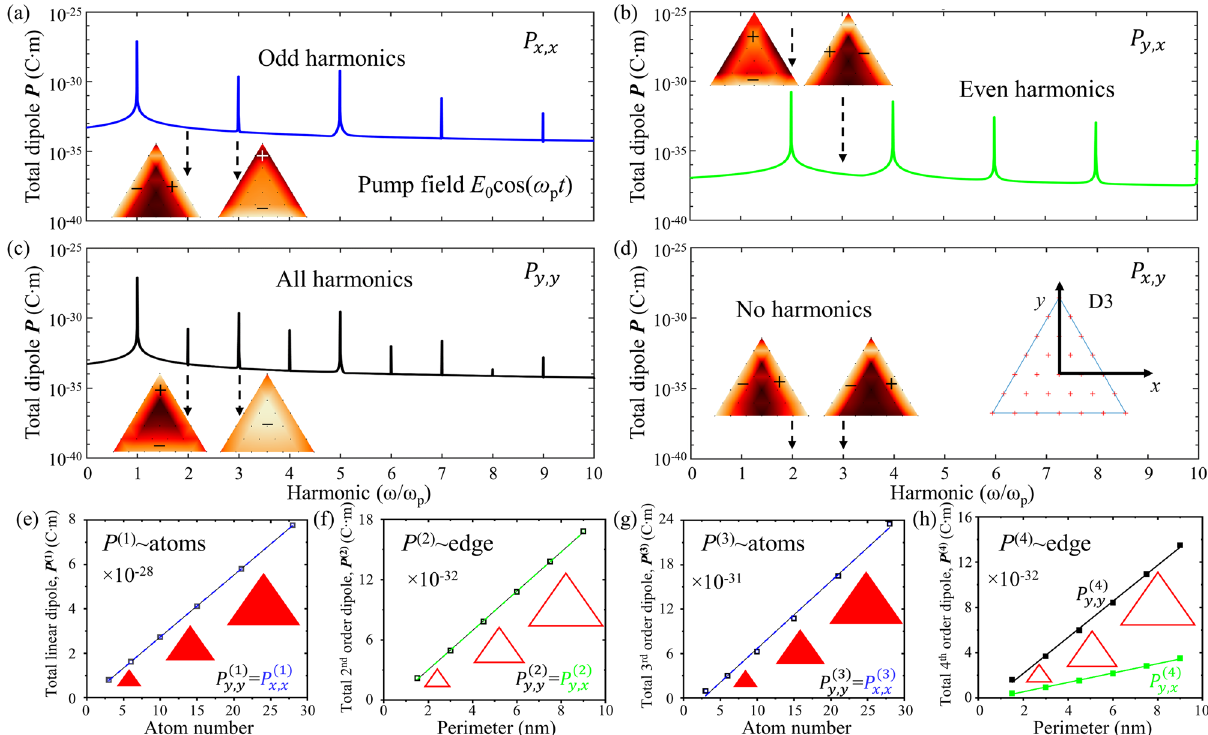
Figure 3. Harmonic generation in a nanoparticle of D3 symmetry. ( a – d ) Frequency-dependence of the electric dipole moment of a triangular particle pumped at frequency ω p . Components of the dipole moment ( a , c ) parallel and ( b , d ) orthogonal to the ( a , b ) x -polarized and ( c , d ) y -polarized pump field. Absence of curves in case ( d ) indicates cancellation of the electric dipole component at all frequencies. The inset shows the outline (blue line) and the 28 atoms (red crosses) of the triangular particle. Colourmaps show the distribution of the atomic dipole moments at the 2nd and 3rd harmonic frequencies, which are representative of even and odd harmonics. Colour represents the dipole magnitude and regions oscillating in anti-phase are indicated by opposite signs as in Fig. 2c. ( e – h ) Scaling of the particle’s dipole moment with its size at the first four harmonic frequencies. The particle’s electric dipole moment scales with its number of atoms (area) at odd harmonics and with its perimeter length at even the particle’s electric dipole moment at even (Fig. 3a), odd (Fig. 3b) or all (Fig. 3d) harmonics results from charge oscillations with equal amplitude and opposite phase at opposite edges of the triangle. It has been reported that the total linear and second-order nonlinear responses of a particle scale differently with its size. For a 3D particle made from centrosymmetric material, the total linear electric dipole moment is proportional to its volume (number of atoms), while the second-order dipole is proportional to its surface area 32 . For a 2D particle, as considered here, the linear electric dipole moment is proportional to its area (number of atoms), while the second-order electric dipole is proportional to its perimeter 41 . However, how does particle size affect higher order harmonics? Fig. 3e–h shows how the electric dipole moment of a triangular 2D particle changes with particle size. The magnitudes of the total dipole moments, P (1) , P (2) , P (3) , P (4) , at the first four har- monic frequencies are shown for triangular particles with perimeter from 1.5 nm (3 atoms in total) to 9 nm (28 atoms). We find that the total nonlinear electric dipole at odd harmonics is proportional to the total number of atoms (2D particle area), while the dipole at even harmonics is proportional to the particle’s perimeter. At the first three harmonic frequencies, x -polarized and y -polarized pump light induce dipole moments of the same ( 4 ) ( 4 ) magnitude, while at the fourth harmonic P y , y = 4 P y , x . Sum frequency generation in the triangular particle is consistent with harmonic generation. An x -polarized pump electric field at a combination of two different frequencies generates a nonlinear electric dipole moment along x for odd sum frequencies and along y for even sum frequencies, while a y -polarized pump field generates a nonlinear dipole moment along y only for all sum frequencies, where more and more sum frequencies are generated with increasing pump amplitude (Supplementary Fig. S4). For sum frequency generation resulting from cross-polarized pump fields of different frequencies see Supplementary Fig. S5. In this case, x -polarized electric dipole moments are generated at sum frequencies containing an odd multiple (1, 3, …) of the x -polarized pump frequency and generated y -polarized sum frequencies contain an even multiple (0, 2, …) of the x -polarized pump frequency.